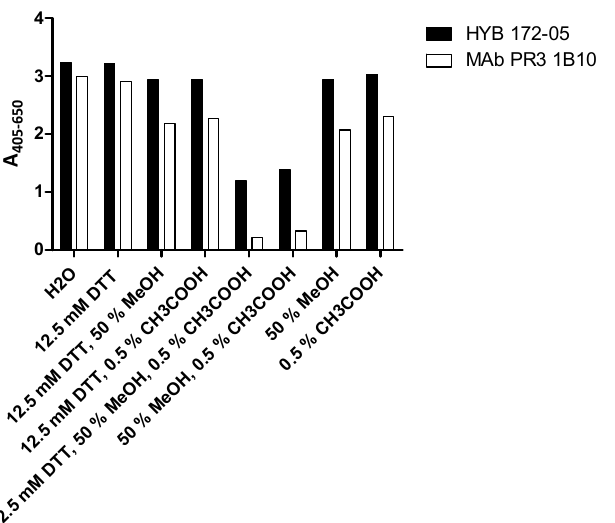
Figure 4. Extraction of coated SSI PR3 and analysis of effect on MAb binding by ELISA.